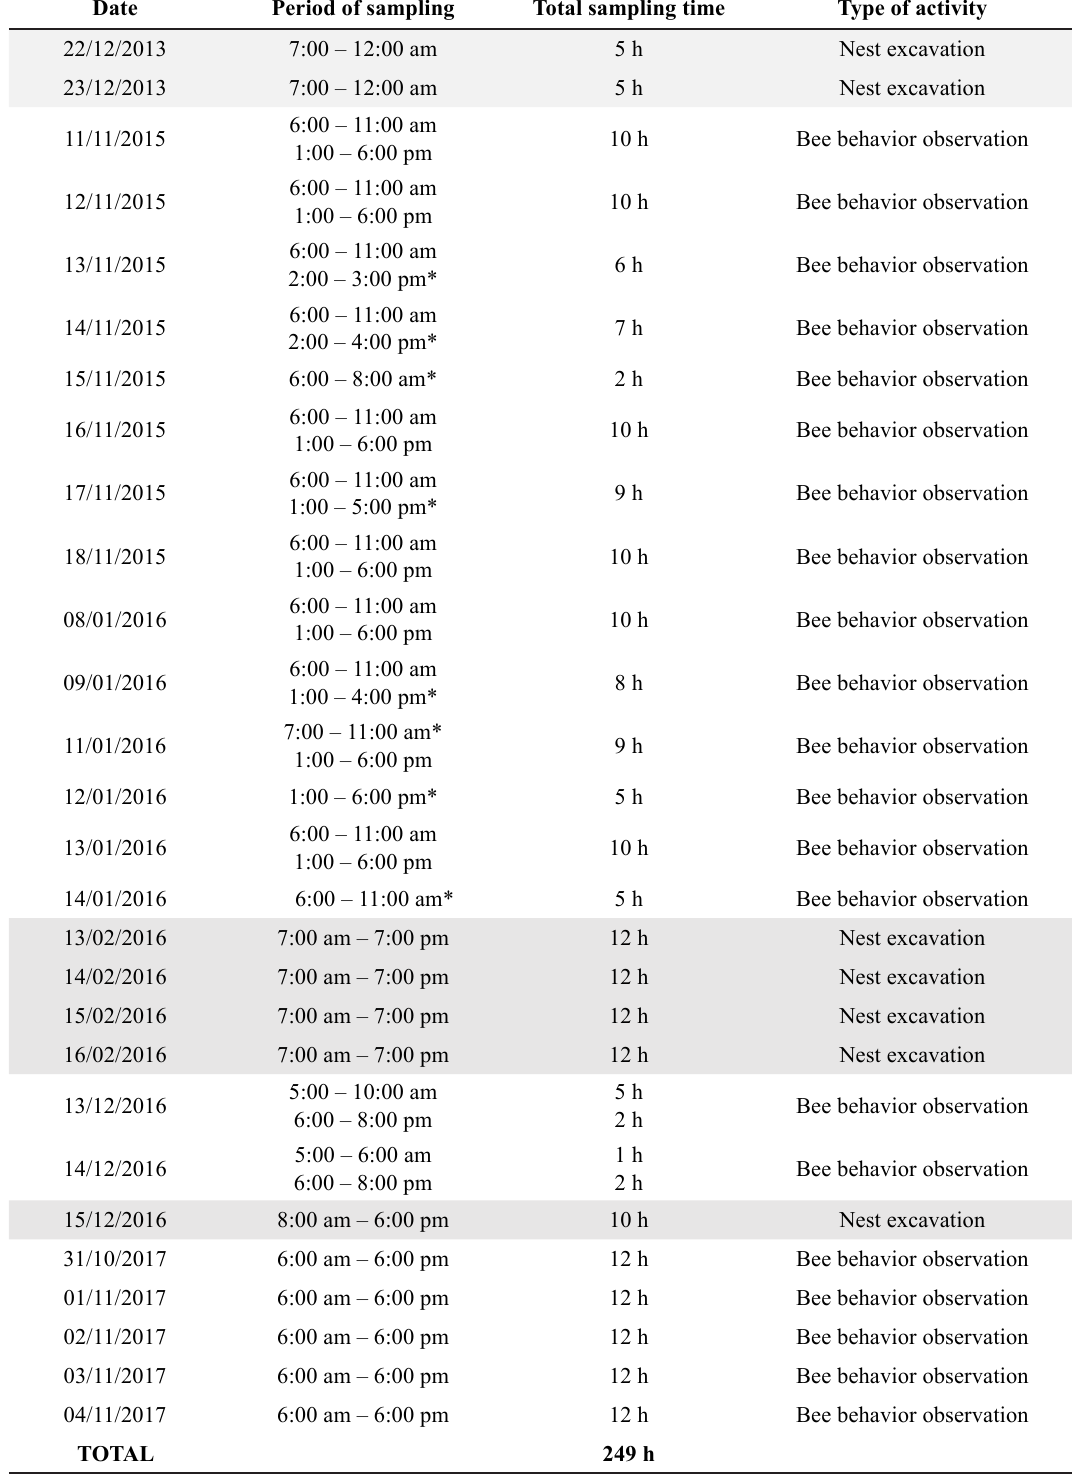
Table S1. Dates of samplings conducted at Ilha do Superagui, state of Paraná, southern Brazil, during some months in warm-wet season, from December 2013 to November 2017, types of activities carried out by study team in each date and total time spent in each sampling